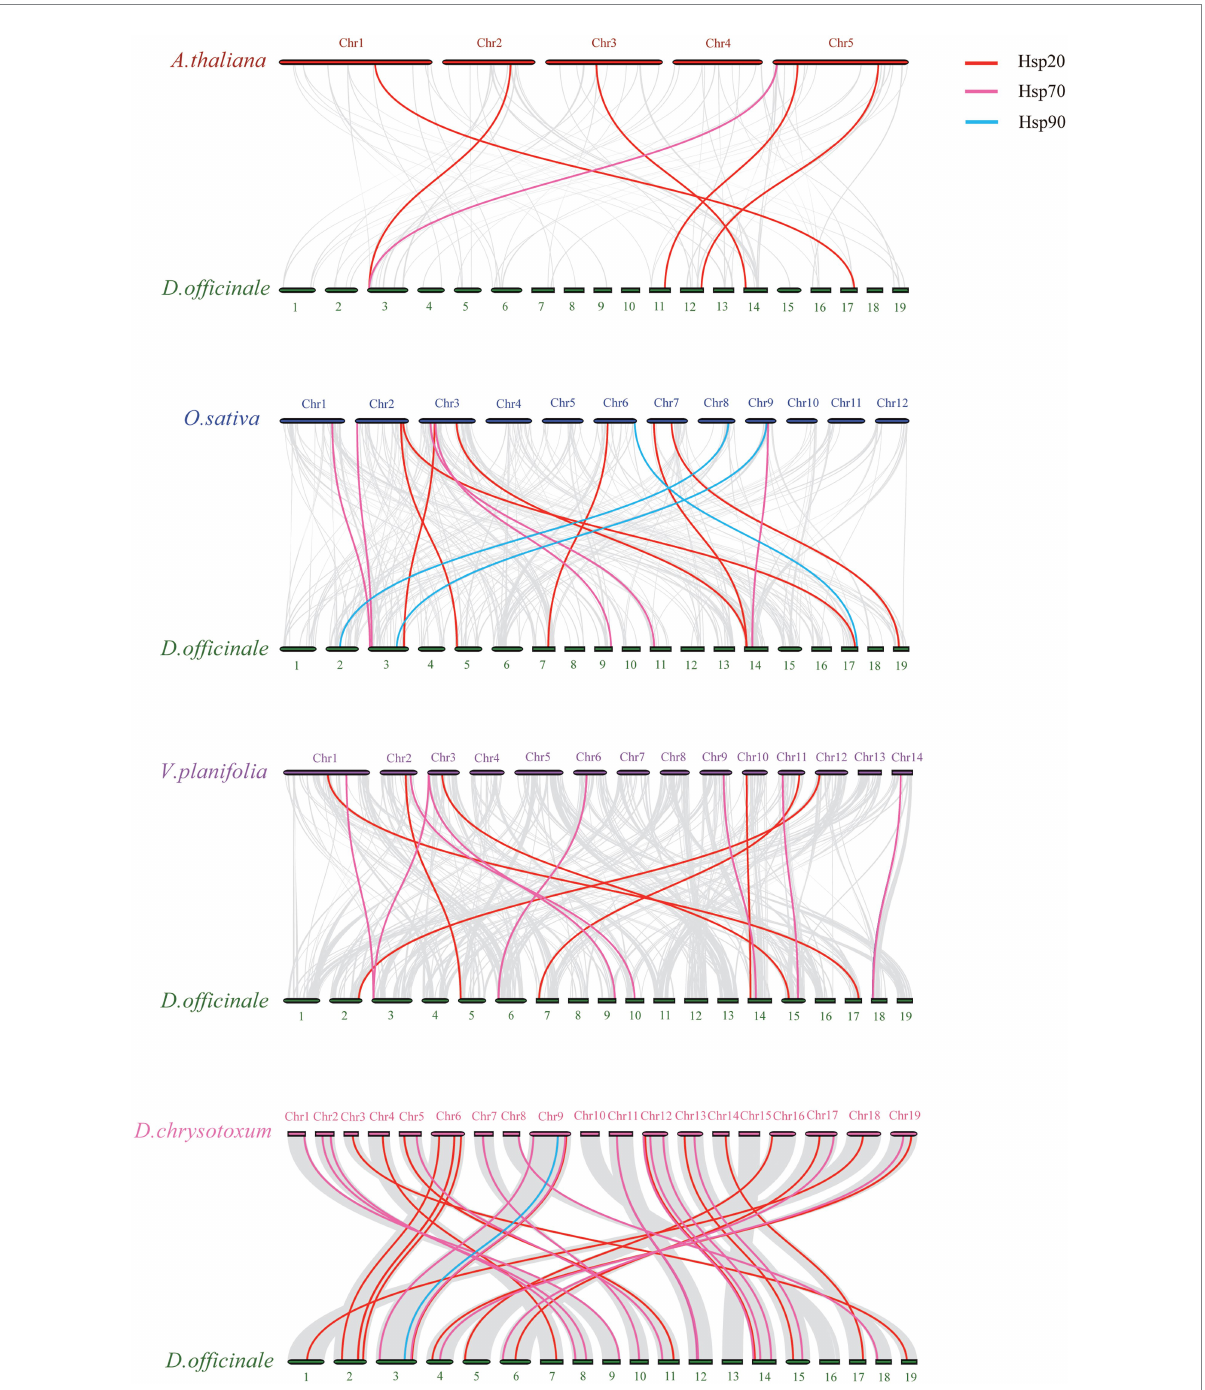
FIGURE 5 Collinearity analysis of Hsp20 , Hsp70 and Hsp90 genes between Dendrobium officinale and four other plants, including A. thaliana , O. sativa , V. planifolia and D. chrysotoxum . Gray lines indicate the collinear blocks. Syntenic genes of Hsp20 , Hsp70 and Hsp90 gene family are exhibited with red, pink and blue lines,